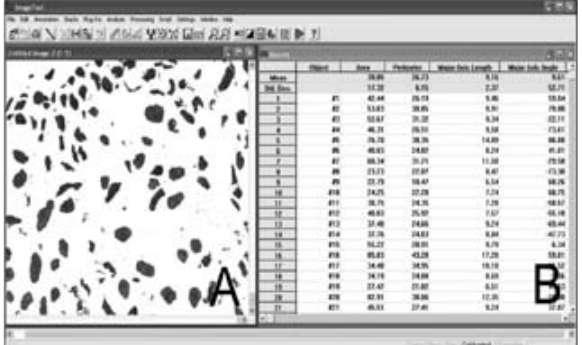
Figura 3 – Interface do programa Image Tool versão 3.0 para Windows. A: os objetos selecionados são circundados e numerados em vermelho; B: os resultados numerados obtidos a partir da seleção anterior